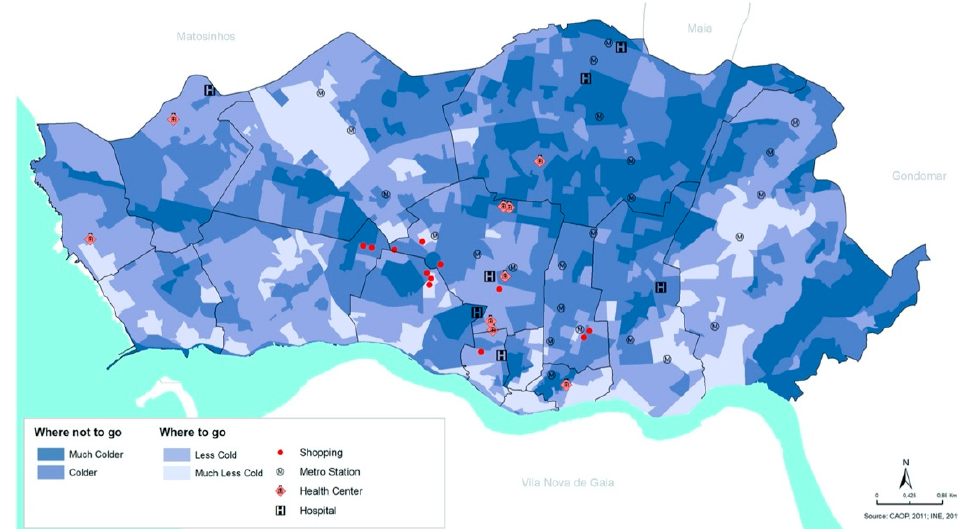
Figure 5. Risks and potential solutions on extremely cold days (surface temperature delivered by Landsat 8, band 10 satellite image).